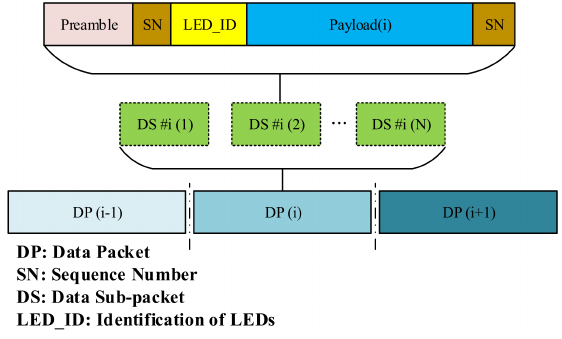
Figure 12. MIMO–COOK data packet structure.